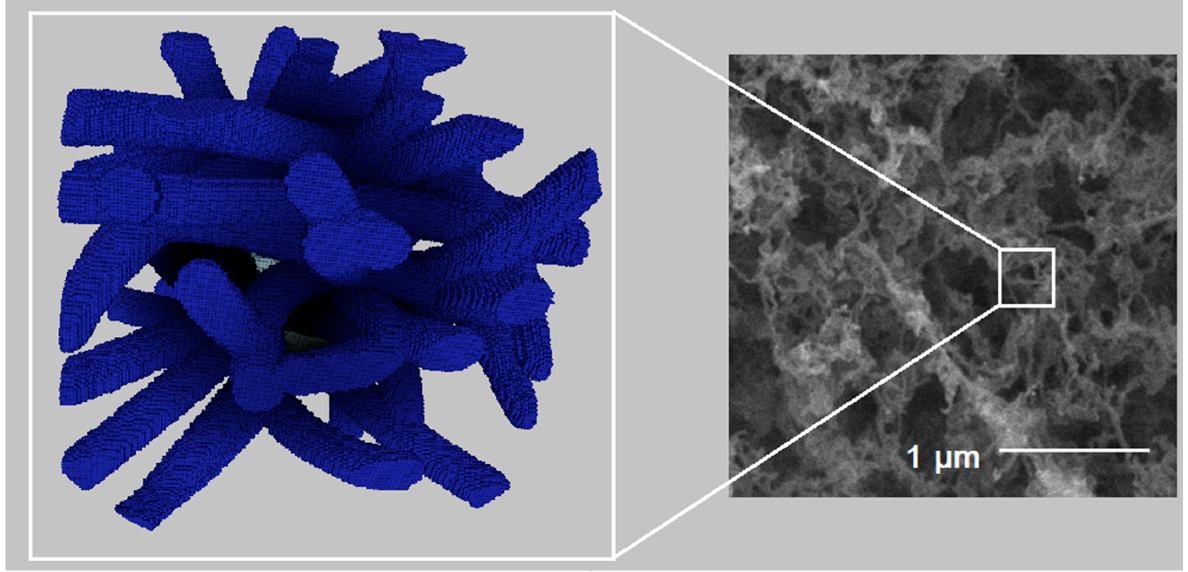
Figure 18. Visual comparison between three-dimensional digital copy and SEM image of sample 6.